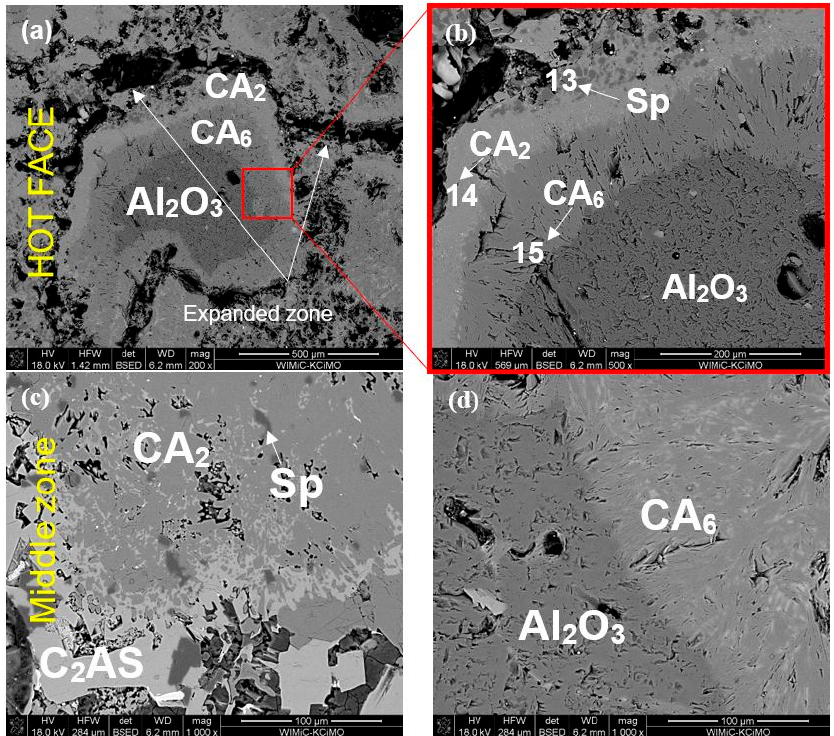
Figure 15. SEM images of sample Al-2-2 corroded by slag S (1450 °C, 10 h); ( a ) hot-face zone of the Al-2-2 sample, ( b ) higher-magnification of ho-face zone, ( c ) middle of the Al-2-2 sample, ( d ) higher magnification of middle zone. Table 6. EDS chemical composition in selected micro-areas indicated in Figures 12–15.